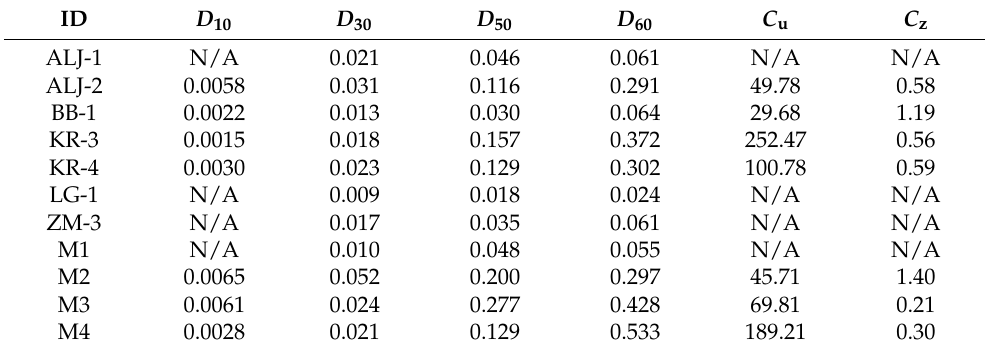
Table 2. Grading parameters of traditional and reproduced mixtures.